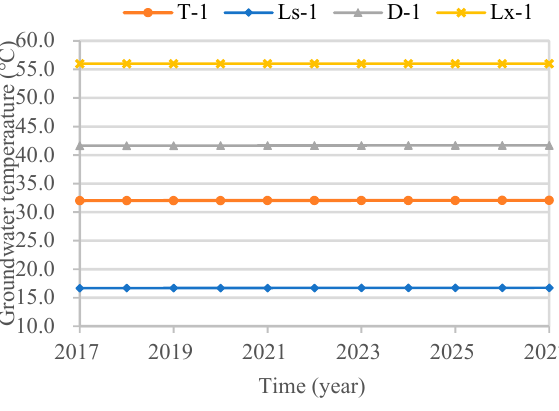
Figure 18. Simulated temperature of different observation points in Layer 1 during the predicted period.